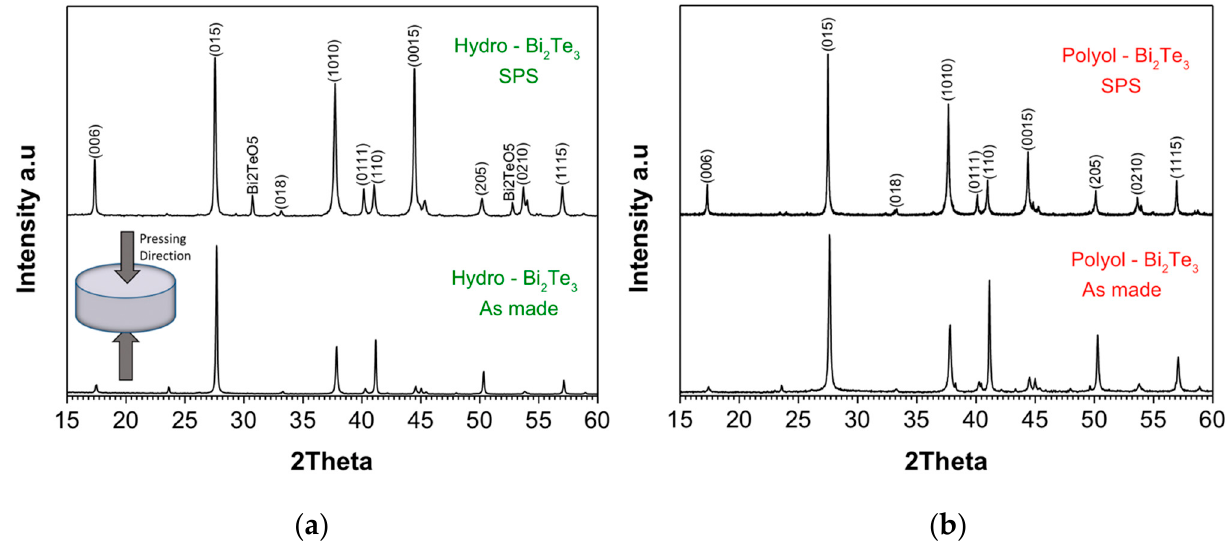
Figure 2. X-ray powder diffraction patterns (XRPD) (normalized for the intensity of the most intense 015 peak) of as- synthesized and spark plasma sintered Bi 2 Te 3 samples synthesized through MW-assisted heating for ( a ) hydro-Bi 2 Te 3 , and ( b ) polyol-Bi 2 Te 3 sample. The major crystalline phases are indexed to Bi 2 Te 3 (ICDD: 01-089-2009) with rhombohedral crystal structure (a = b = 4.3860 Å, c = 30.4970 Å; α = β = 90°, γ = 120°).